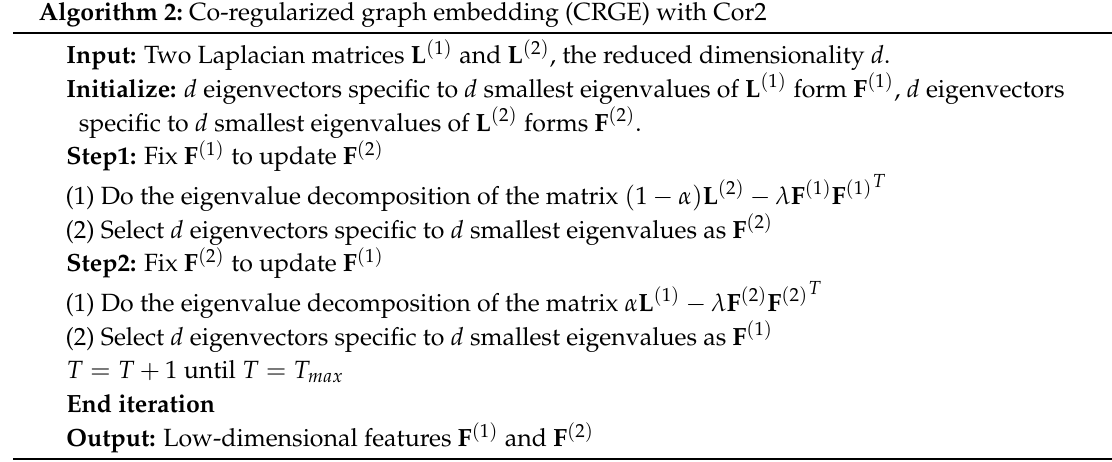
Algorithm 2: Co-regularized graph embedding (CRGE) with